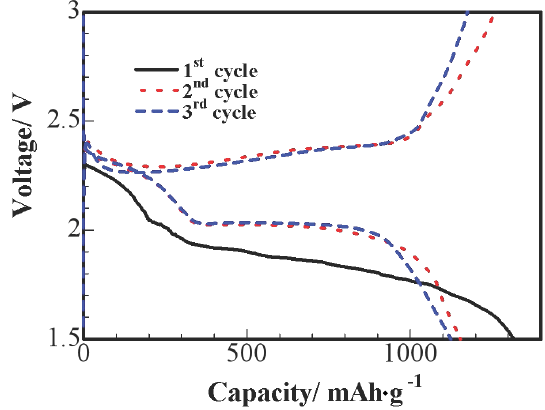
Figure 6. Charge/discharge potential profiles of S/HPC composite cathode at 0.1 C.